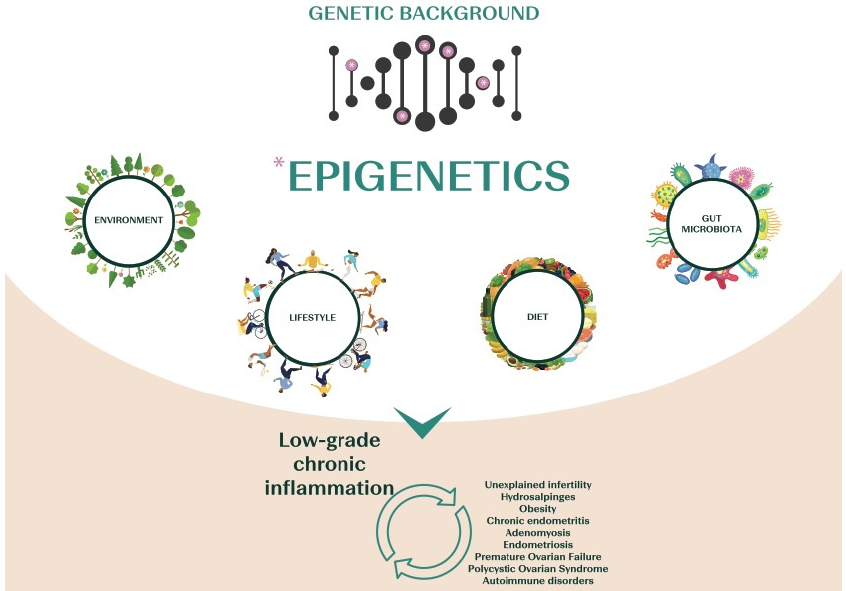
Figure 1. Scheme of the main causative factors of chronic low-grade inflammation, a state that characterizes several infertility-related diseases.